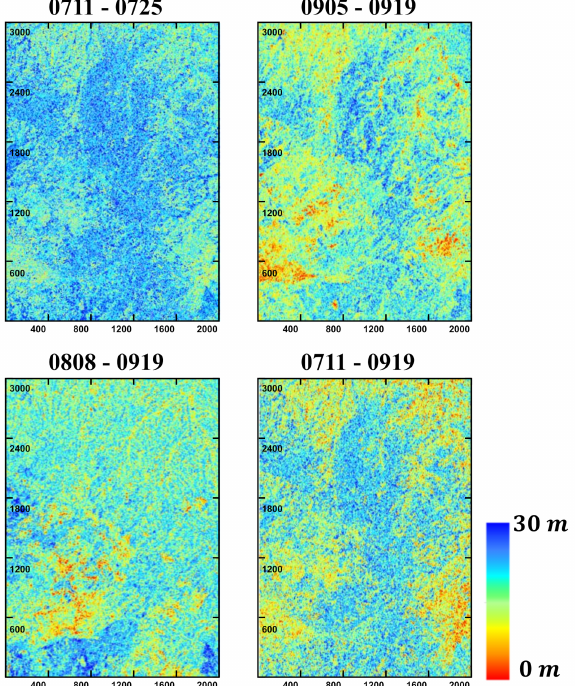
Figure 17. Inversion of forest height using different